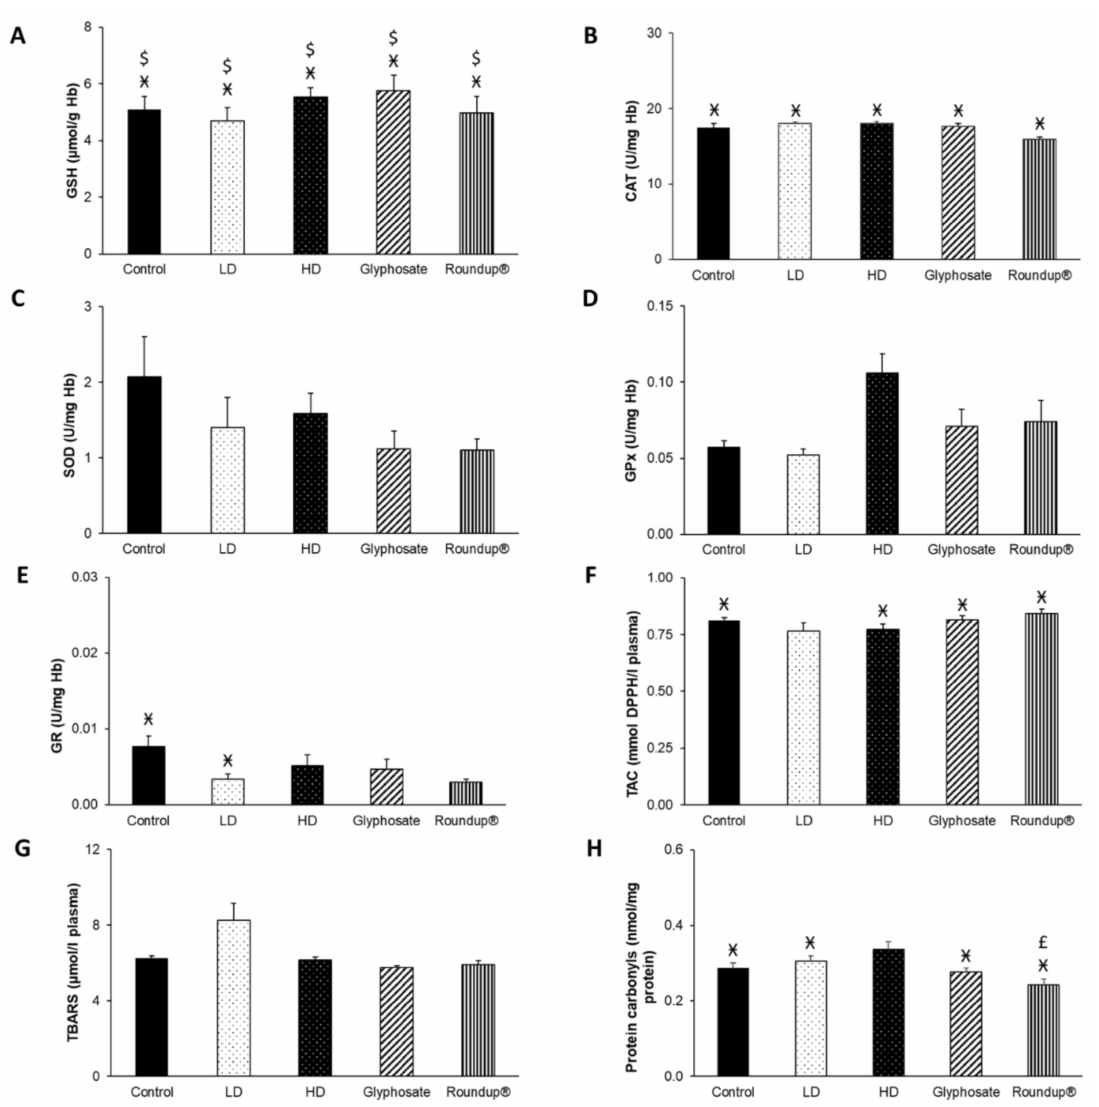
Figure 5. The effects of 12-month exposure of New Zealand rabbits to the EDs mixture, glyphosate, and Roundup ® on blood GSH concentration ( A ), CAT activity ( B ), SOD activity ( C ), GPx activity ( D ), GR activity ( E ), TAC levels ( F ), TBARS levels ( G ), and protein carbonyls concentration ( H ). Ӿ : Statisti- cally significant difference within the same group compared to 3 months. £: Statistically significant difference within the same group compared to 6 months. $: Statistically significant difference within the same group compared to 9